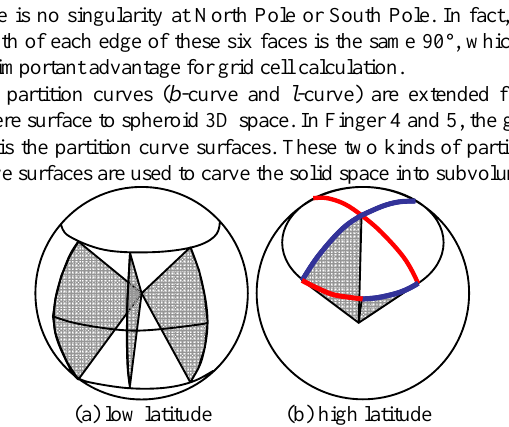
Figure 8. ROS near north